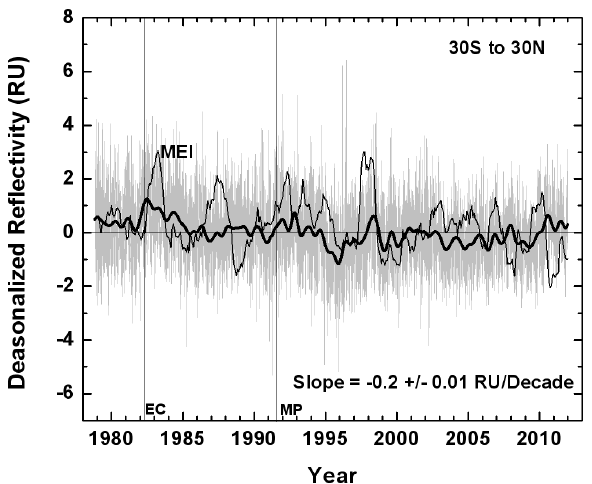
Fig. 7. Deseasonalized LER time series for 30 ◦ S to 30 ◦ N (grey) with a superimposed 90-day low-pass filter (thick black) and the MEI (thin black). The lines labeled EC and MP represent the dates of the El Chichon (April 1982) and Mt. Pinatubo (June 1991) vol- canic